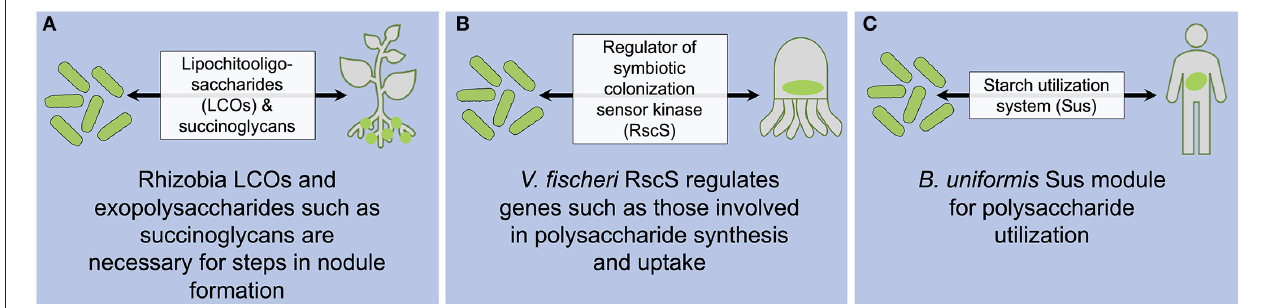
FIGURE 1 | Strain specificity factors that fulfill a functional role in hosts in rhizobia-legume (A) , V. fischeri -squid (B) , and B. uniformis-human (C) associations. LCOs indicate lipochitooligosaccharides, RscS indicates regulator of symbiotic colonization sensor kinase, and Sus indicates starch utilization